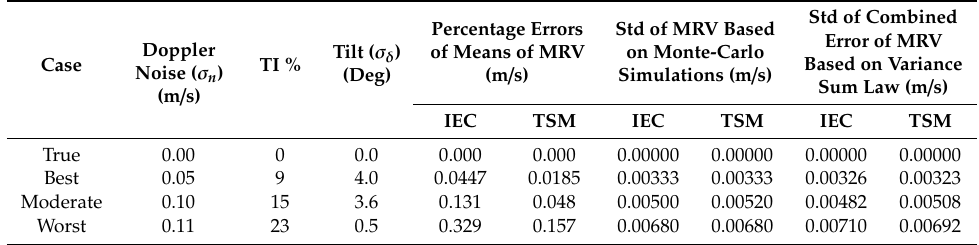
Table 5. The MRV variation due Doppler noise, turbulence and tilt at three selected levels. TI: Turbulence Intensity, MRV: Mean Representative Velocity, IEC: International Electrotechnical Commission and TSM: Temporal- Spatial Method.